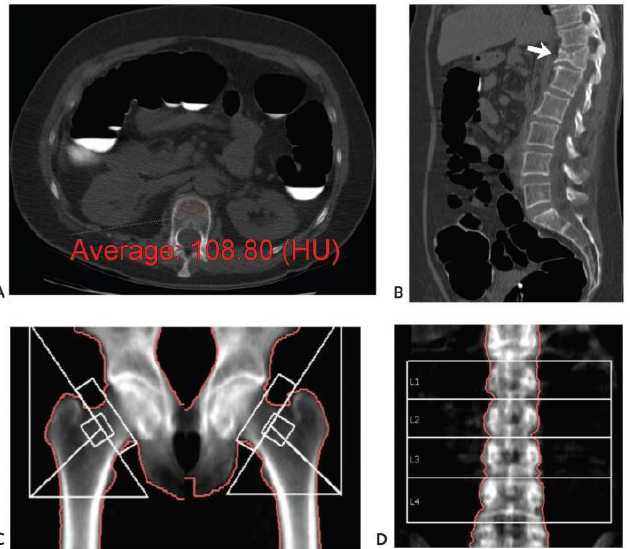
Figure 1. Identification of bone quality based on the HU value of a CT scan. ( A ) axial; ( B ) sagittal, from abdominal CT scan with a moderate compression fracture (arrow). ( C ) pelvic bone; and ( D ) T-score from DEXA data where L1-L4 are a vertebral levels. [11].